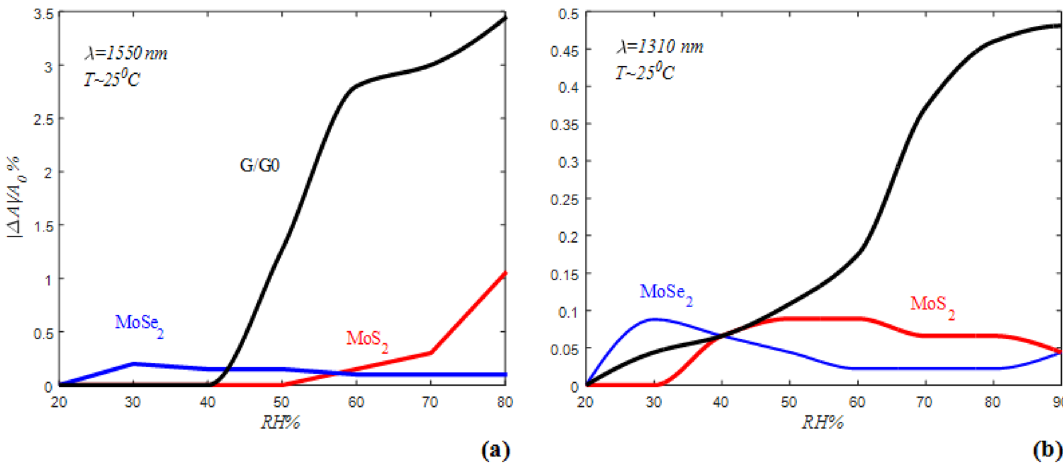
Figure 6. ( a,b ) RDA as a function of RH at room temperature with 1550 and 1310 nm wavelength for different coating